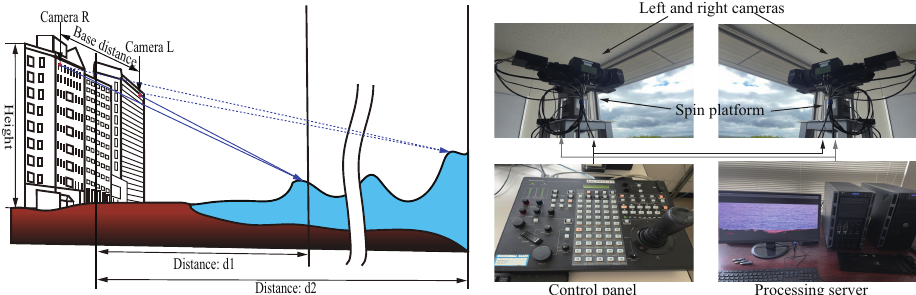
Figure 3. Configuration of the proposed tsunami measurement system (on the left is the schematic diagram and on the right is the main equipment of the proposed